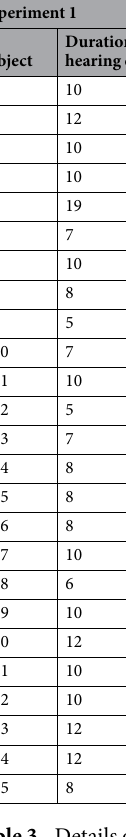
Table 3. Details of Deaf participants (Experiment 1 and